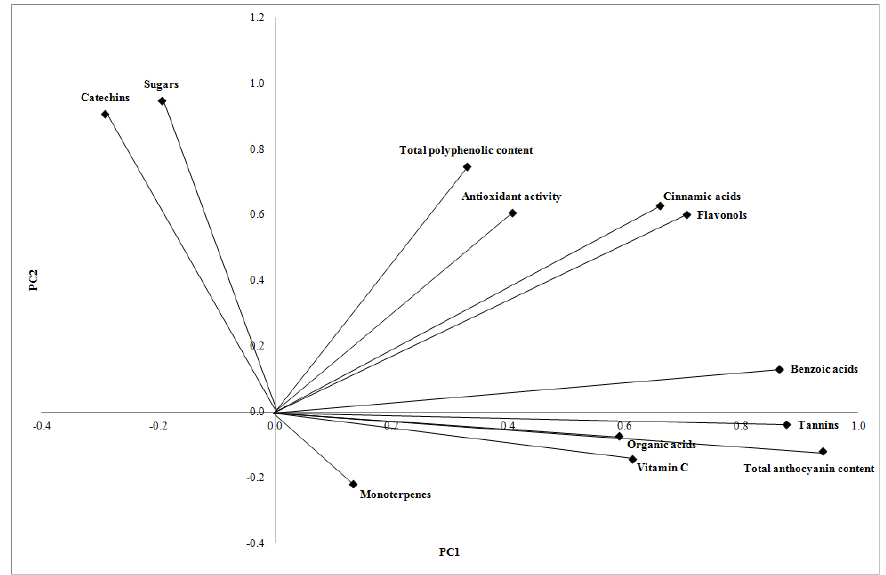
Figure 6. PCA loading plot of fruit ‐ based products showing correlation among nutritional traits, nutraceutical properties and bioactive compound classes and PCs. nutraceutical properties and bioactive compound classes and